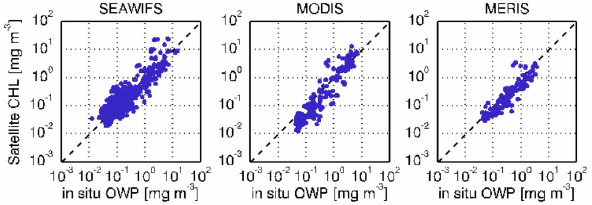
Fig. 3. Scatter plots of the in situ OWP(x-axis) versus the stan- dard satellite-derived operational CHL observations. Left, middle and right panels represent SeaWiFS, MODIS and MERIS, respec- tively. Relevant statistics is shown in Table